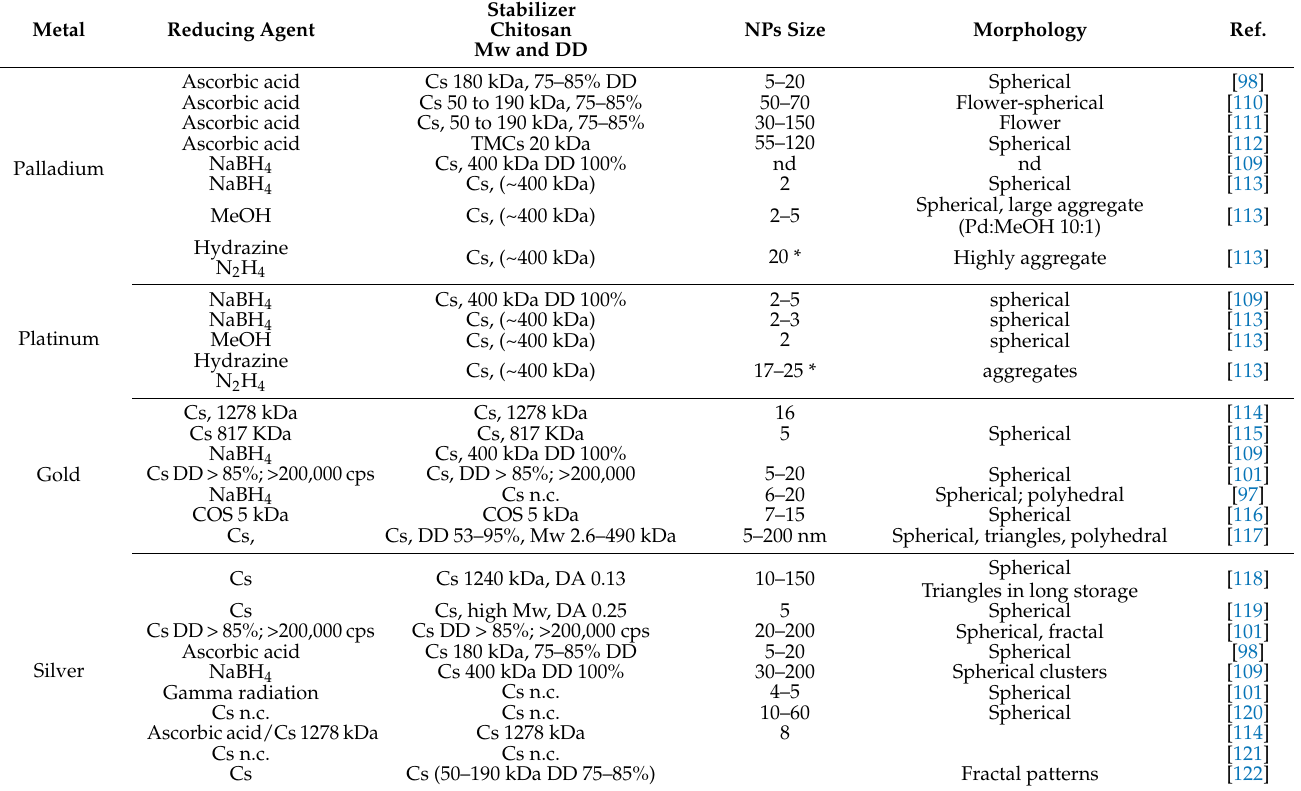
Table 4. Metallic nanoparticle based on chitosan.